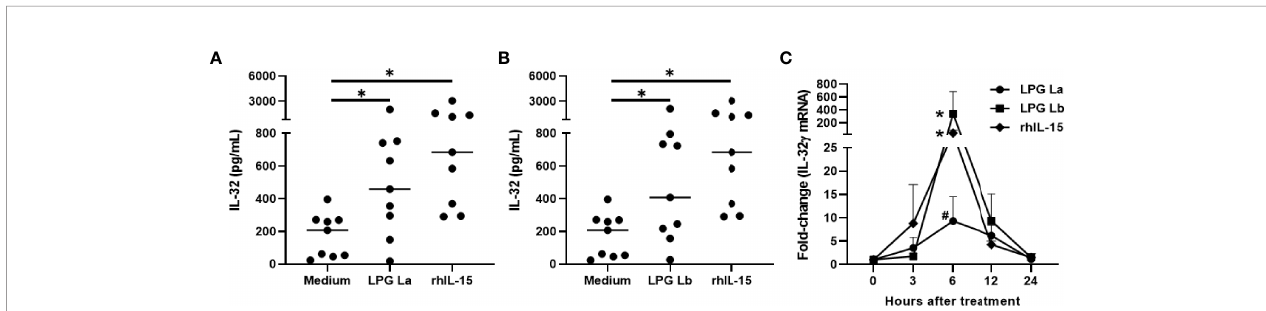
FIGURE 1 | Lipophosphoglycans from Leishmania spp. induces IL-32 production and IL-32 g expression in human mononuclear cells. PBMCs (5 x 10 5 cells/200 µL) were stimulated with LPG (10 µg/mL) of (A) L. amazonensis (La), (B) L. braziliensis (Lb) or (A, B) rhIL-15 (100 ng/mL). Cell lysates were obtained after 24 h of culture and IL-32 was measured by ELISA. (C) PBMCs were incubated for different periods with LPG (10 µg/mL) from L. amazonensis (La) or from L. braziliensis (Lb) or rhIL-15 (100 ng/mL). The IL-32 g mRNA transcripts were analyzed and quanti fi ed by qPCR, using the GAPDH gene as a reference gene. In (A, B) , the data represent the median and individual values (n = 9). *p < 0.05, in relation to the control (Anova Kruskal-Wallis followed by Dunn ’ s post hoc test). In (C) data represent mean and standard error of mean (n = 6). *p < 0.05 (vs. time 0); # p = 0.06 (vs. time 0) (Two-way Anova followed by Bonferroni ’ s post hoc